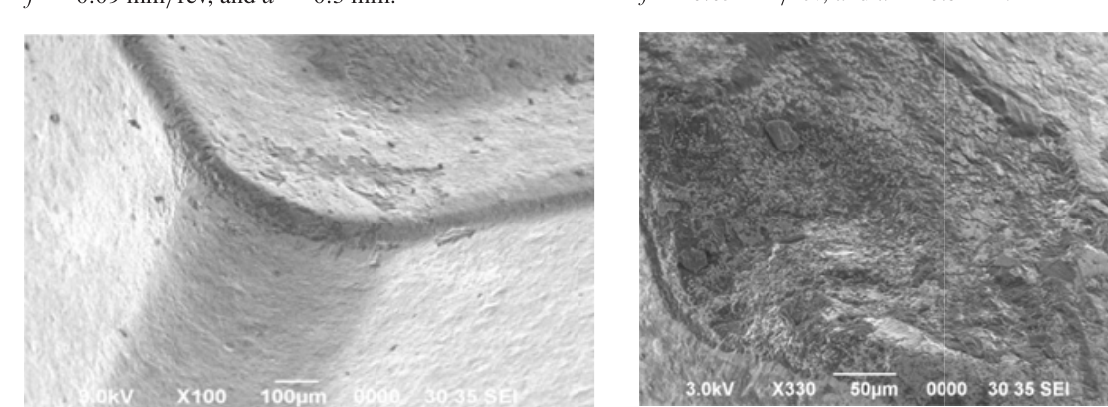
Figure 14. Crater wear at V c D 60 m = min, f D 0:09 mm = rev, and d D 0:3 mm.